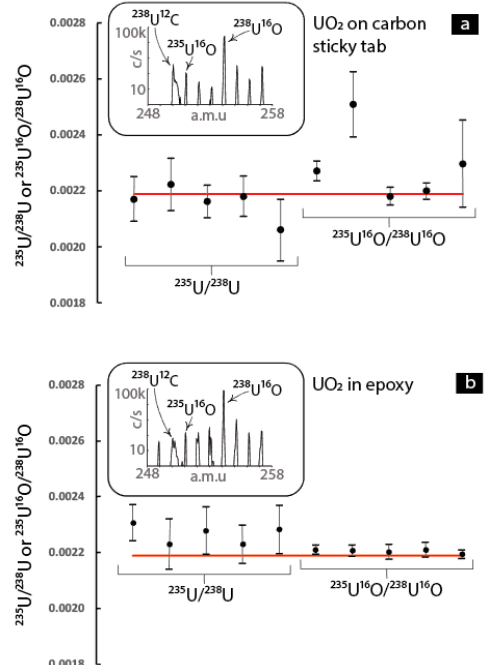
Figure 11. Comparison of 235 U / 238 U vs. 235 U 16 O / 238 U 16 O for UO 2 that was mounted in epoxy ( a ) as well as dispersed on a sticky carbon tab ( b ). Mass scans, from mass 248 to 258, acquired for both sample preparation approaches are shown as insets. While the 238 U 12 C peak is visible in both scans, the 238 U 12 C peak is ~1000 counts / second for the UO 2 dispersed on the sticky carbon tab whereas it is ~100 counts / second for the UO 2 mounted in epoxy. The 235 U / 238 U and 235 U 16 O / 238 U 16 O data used to construct these plots were collected in a separate session (March 2019) and can be found in their own section at the end of Table S1, while the mass scan data can be found in Table S2.